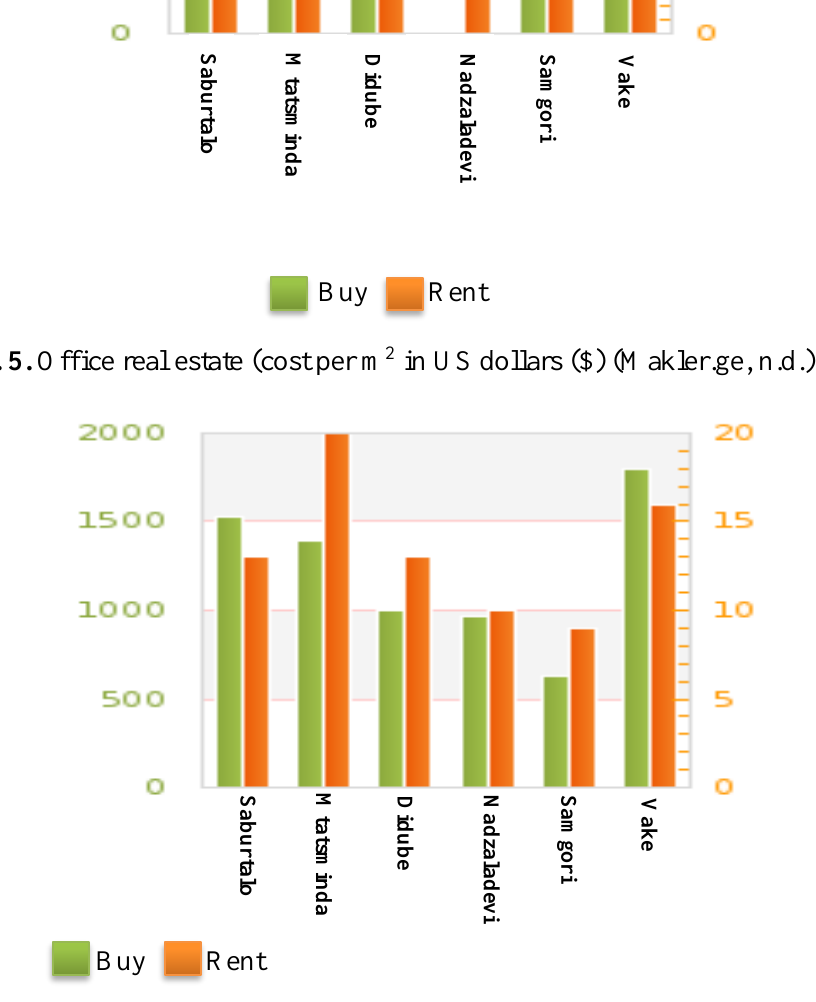
Fig. 6. Commercial real estate (cost per m 2 in US dollars ($) (Makler.ge,